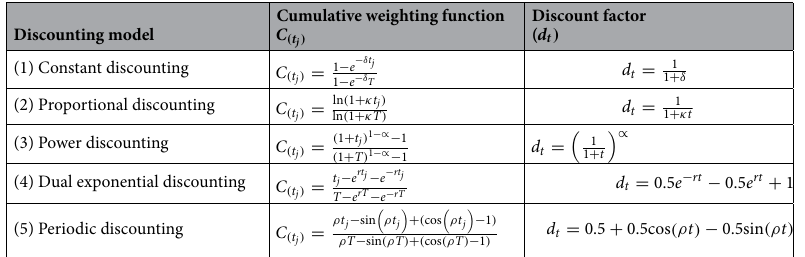
Table 1. Cumulative weighting functions and discount factor equations. Remark: δ, κ, ∝ , r, and p represent parameters governing discounting